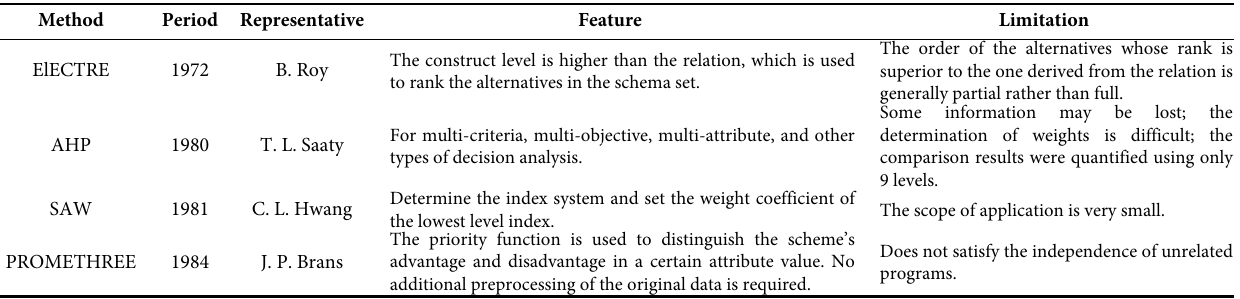
Table 1 Group decision parameter sensitivity analysis